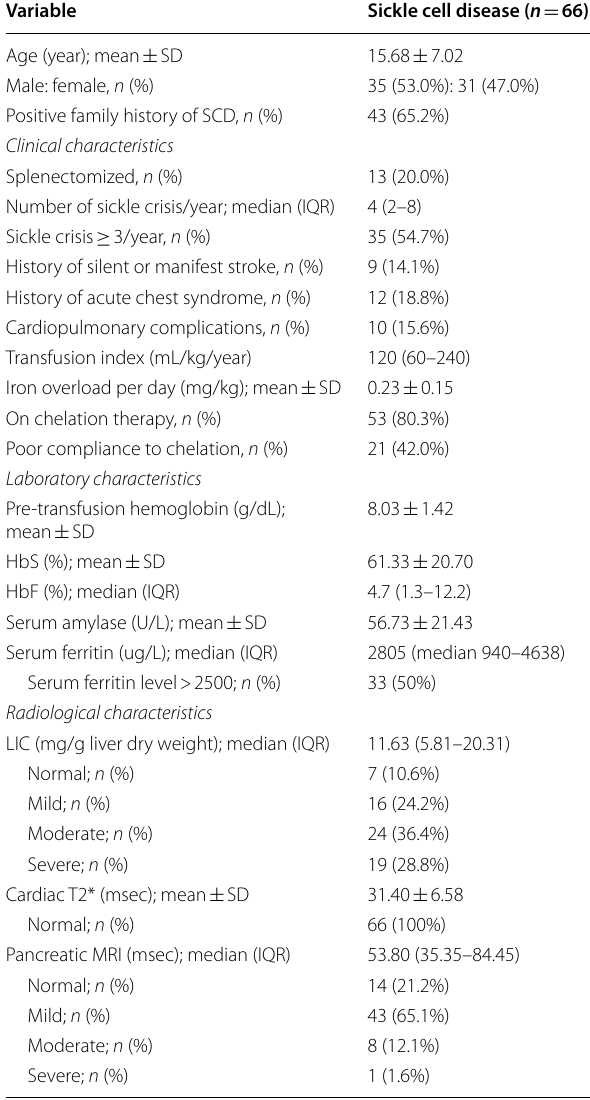
Table 1 Characteristics of the studied patients with sickle cell